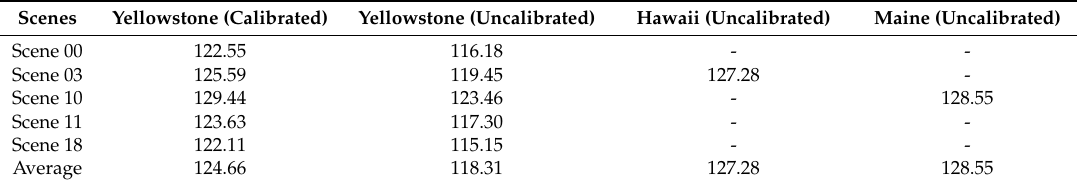
Table 6. Achieved results in terms of PSNR, by embedding w 2 (Dataset 2).